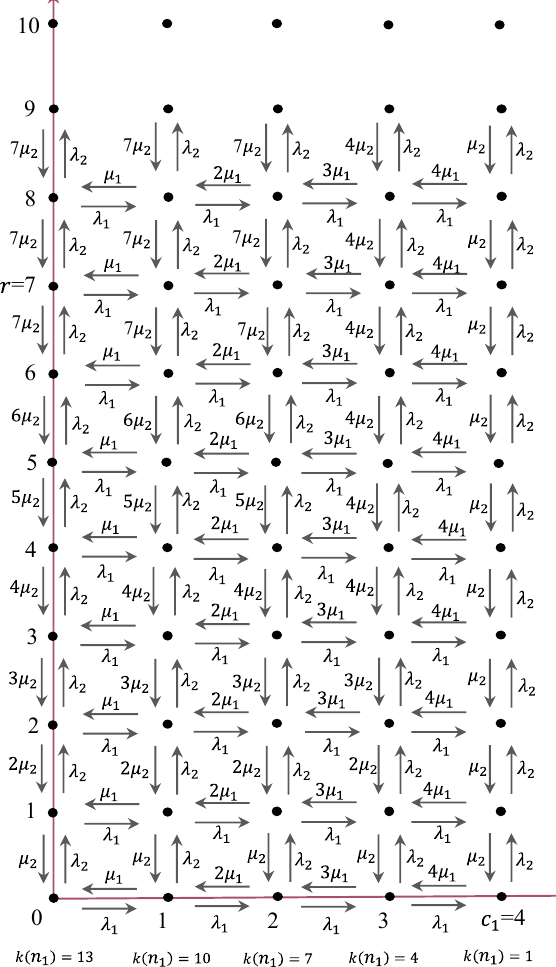
Figure 5. State transition diagram of proposed dynamic spectrum access strategy.